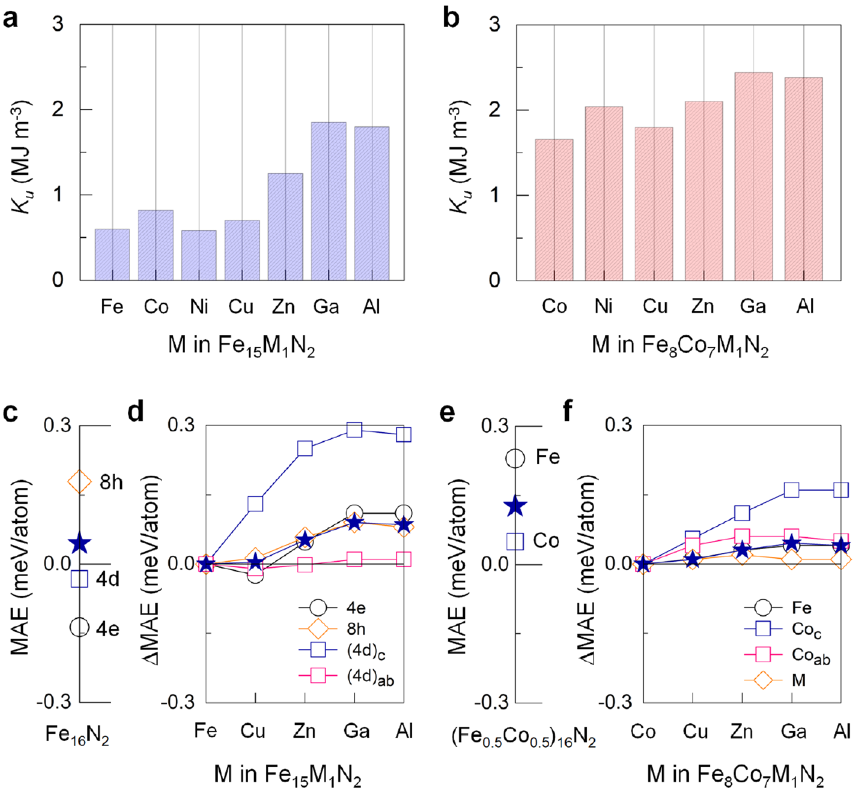
Figure 3. Predicted uniaxial magnetic anisotropy K u of ( a ) Fe 16 N 2 and ( b ) (Fe 0.5 Co 0.5 ) 16 N 2 with M replacement (M = Co−Ga and Al). ( c , e ) Atom-decomposed (open symbols) and total (filled star) magnetocrystalline anisotropy energy MAE, ( d , f ) M (Cu−Ga and Al)-induced enhancement in MAE ( (cid:31) MAE ) of Fe 16 N 2 and (Fe 0.5 Co 0.5 ) 16 N 2